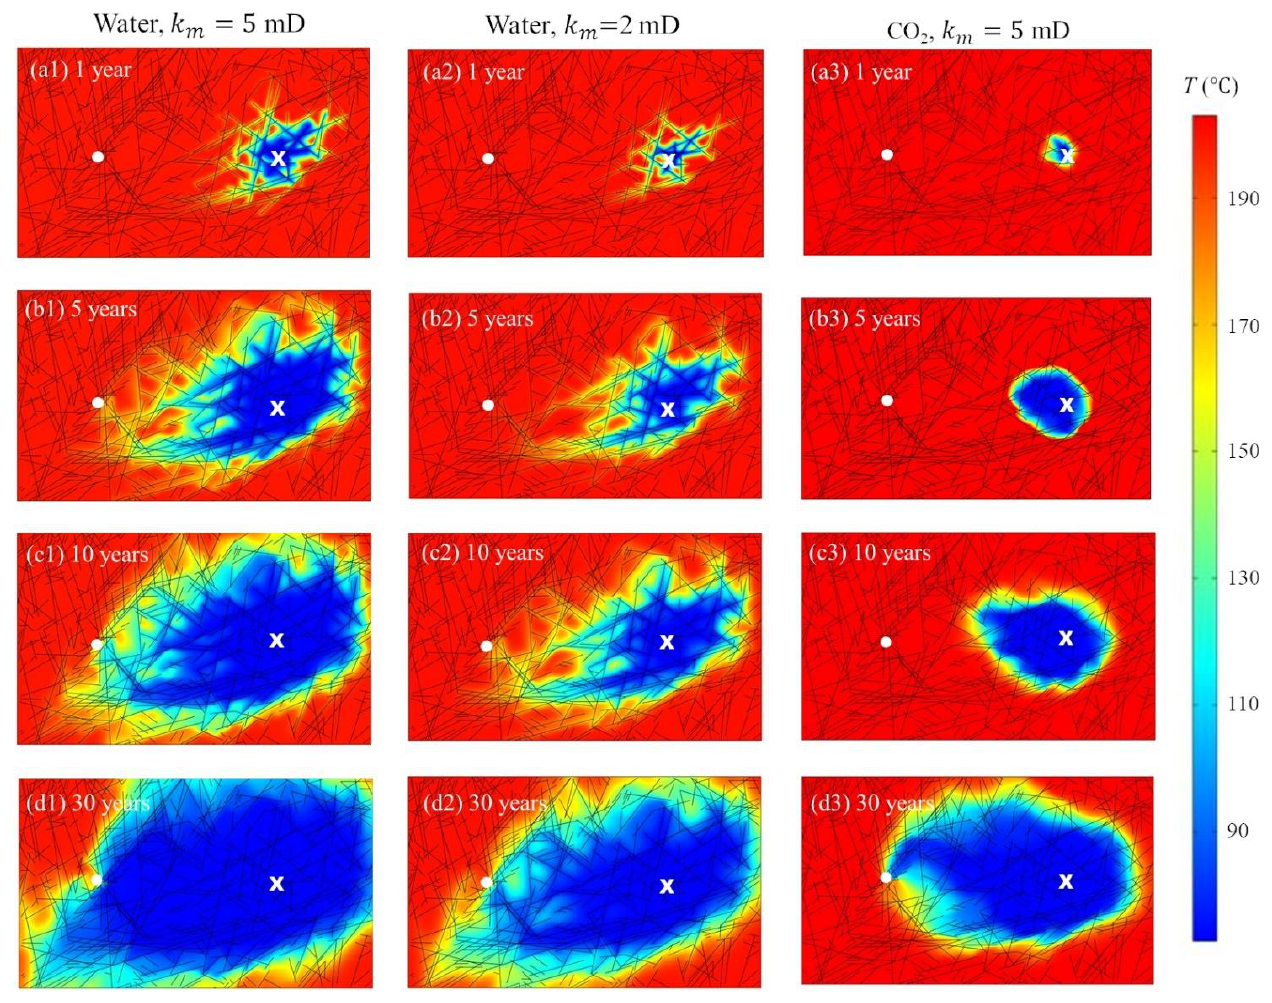
Figure 4. Reservoir temperature distribution at time 1 year ( a1 – a3 ), 5 years ( b1 – b3 ), 10 years ( c1 – c3 ) and 30 years ( d1 – d3 ) when the injection well is present at 180 and the production well is placed at 0. Results from water for reservoir permeability 5 mD and 2 mD are shown by ( a1 – d1 ) and ( a2 – d2 ) respectively. CO 2 as working fluid results are displayed in ( a3 – d3 ). The reservoir permeability for CO 2 simulations is 5 mD. The injection wellbore position is shown by cross symbol whereas a circle indicates production wellbore position.